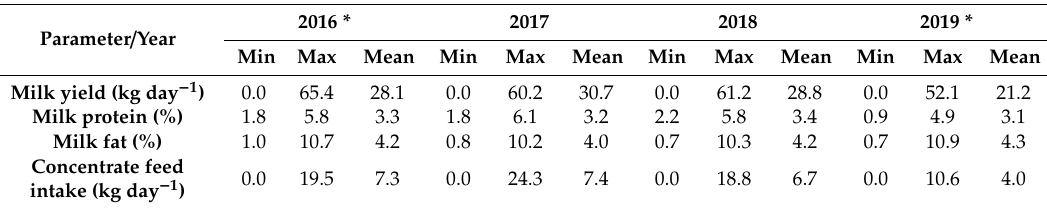
Table 2. Minimum, maximum, and mean values of the parameters used as targets to develop the machine learning models.